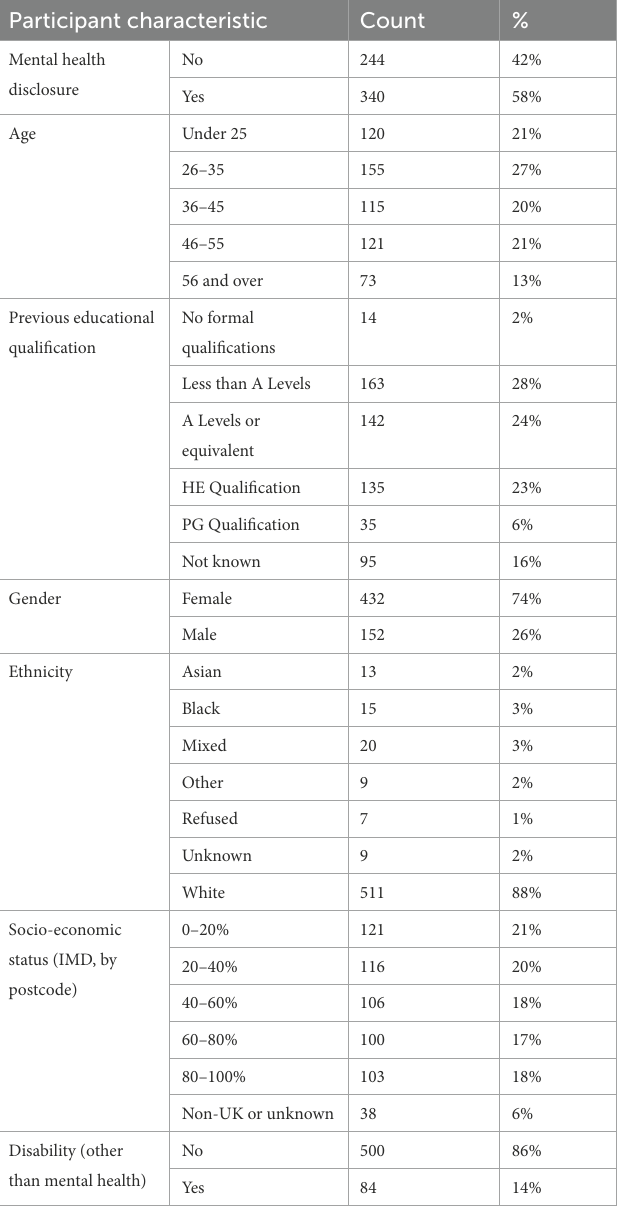
TABLE 1 Survey respondent demographics. Participant